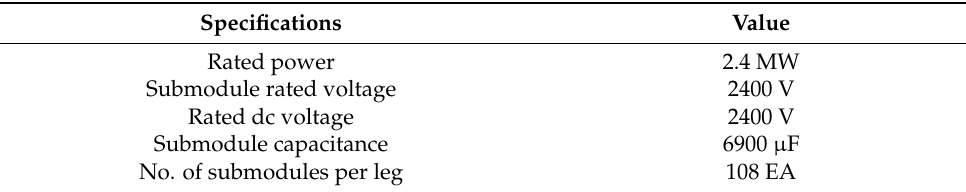
Table 1. Design parameter of